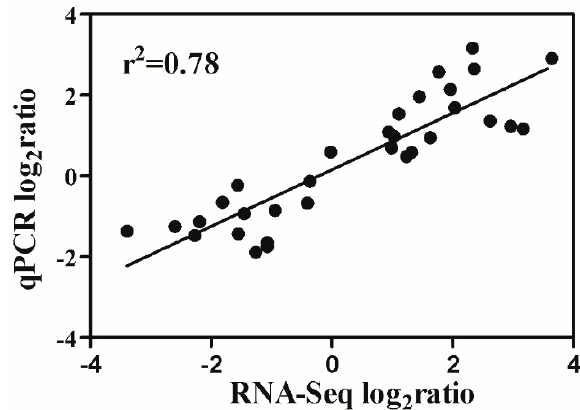
Figure 6. Correlation analysis of gene expression values obtained from RNA-seq and data obtained using real-time qPCR. All qPCR reactions were performed in three biological replicates. Values are the log 2 ratio(T/CK) for genes. The determined coefficient (r 2 ) is indicated in the figure.